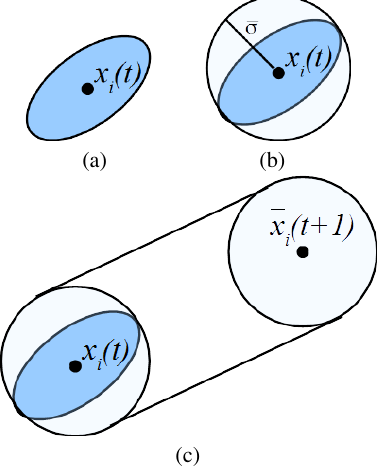
Figure 3: UAV safety zone, shown in 2D to ease the readability of the figure. (a) uncertainty on the x i ( t ) position. (b) spherical upper bound of the uncertainty on the x i ( t ) position. (c) UAV safety zone between position at time t and expected position at time t + 1